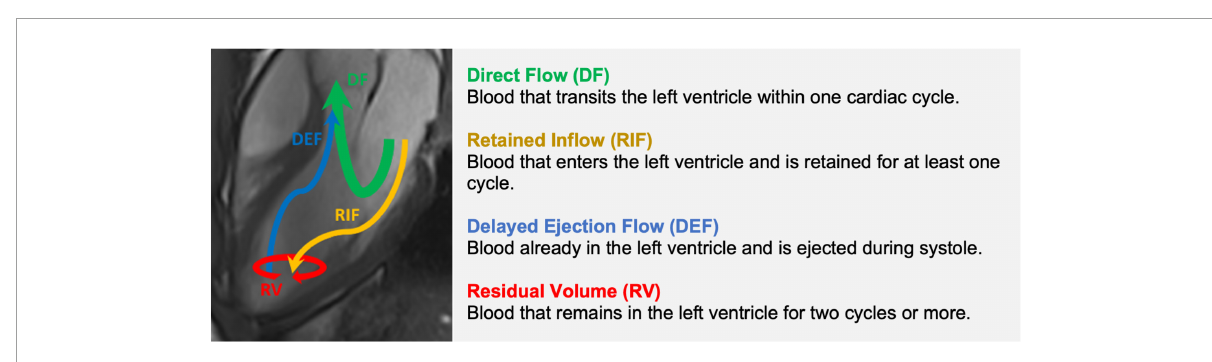
FIGURE7 Constituent functional flow components of left ventricular blood